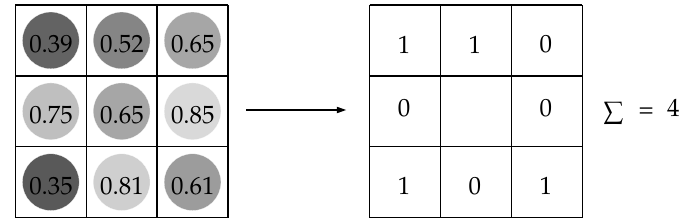
Figure 6. The rank